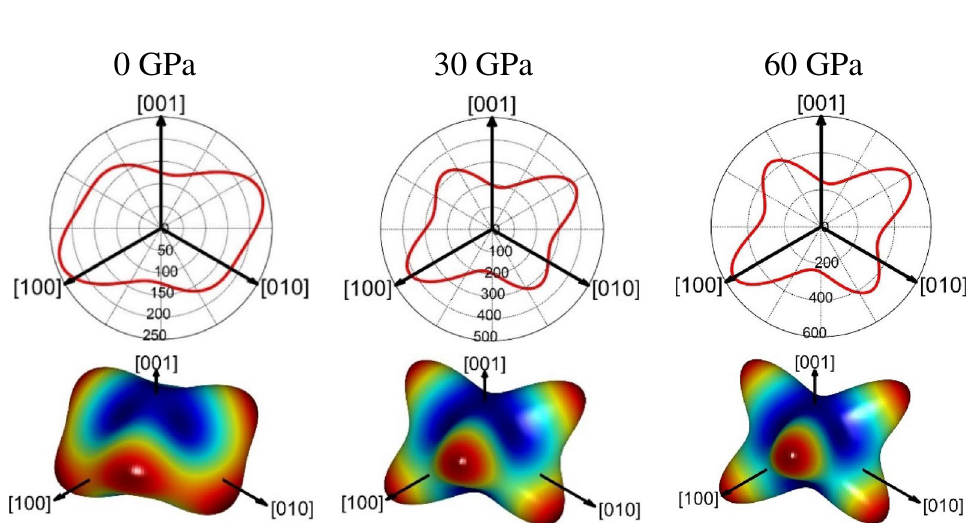
Figure 7. 3D spatial distribution and its projection of Young’s modulus for magnesite at various